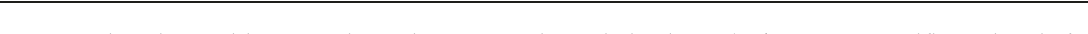
Fig. 4 Genotype-dependent candidate DMRs that mediate genetic risk in multiple sclerosis (MS). a Summary work fl ow and results for identifying epigenetically mediated genetic risk factors for MS. The diagrams on the right represent the relationships between genotype (G), DNA methylation (M), and MS (phenotype, Y). Dashed lines, the association relationship; arrows, the causal relationship. b Association between candidate genetic risk-mediating DMRs and genotype. Each dashed line represents a potential mediation relationship between an SNP and a DMR as determined by the CIT. c Association between DNA methylation levels at DMR4 chr6:32552039-32552350 (located in exon 2 of HLA-DRB1 ) that mediates genetic risk in MS and phenotype (top panels), with red and blue colors representing cases and controls, respectively, in blood cells ( n = 279) (top left), and in sorted CD14 + monocytes ( n = 36), CD19 + B cells ( n = 29), CD4 + ( n = 33), and CD8 + ( n = 29) T cells for cg08578320 (top right), or genotype rs3135338 (bottom left panel) with blue, black, and red colors denoting AA, Aa, and aa genotypes. Bottom right panels: association between genotype (rs3135338) and phenotype and CIT. Red horizontal bars mark percentage of cases for each genotype. Coef fi cient ( β ) represents the dependence of the MS phenotype on genotype, with or without adjusting for DNA methylation. The error bars represent the 95% con fi dence interval for the coef fi cient β . In the case of the methylation-mediated model, the absolute value of the observed G:Y relationship strength reduces toward zero when adjusting for methylation. DMR: differentially methylated region, SNP: single nucleotide polymorphism, CIT: causal inference test. The full list of SNP-DMR pairs is shown in Supplementary Data